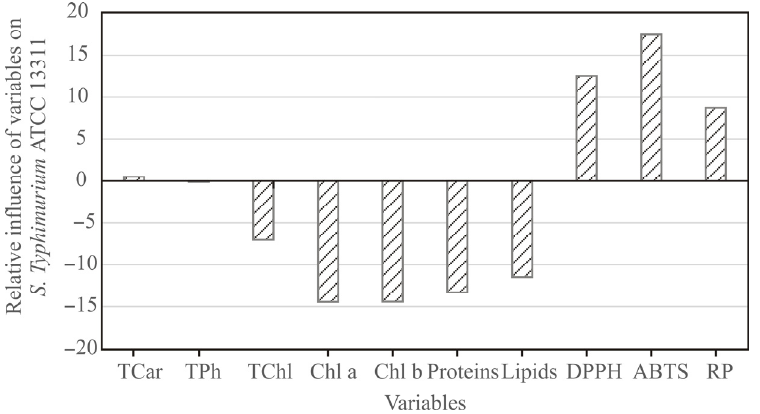
Figure 6. The relative importance of input variables on S . ser. Typhimurium in pulp